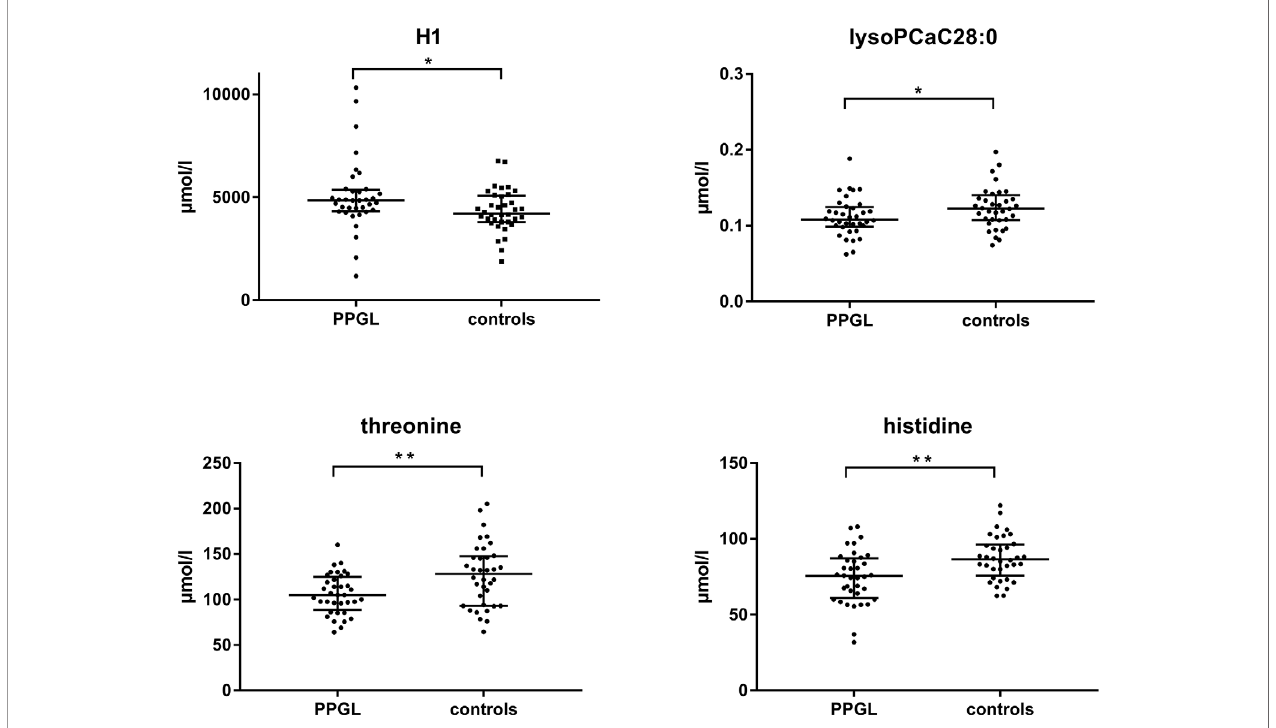
FIGURE 2 | Scatter plot of median plasma levels from metabolites measured by LC-MS/MS with signi fi cant differences between PPGL patients and controls. (Mann-Whitney-U-test, p < 0.05). H1, sum of hexoses; lysoPC, lysophosphatidylcholine; PPGL, pheochromocytoma and paraganglioma. *<0.05,